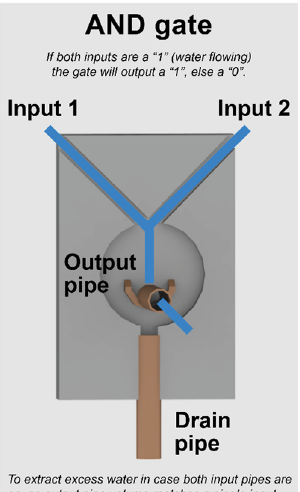
Figure 1: Example mechanism by which water stream inputs can serve as an AND logic gate.